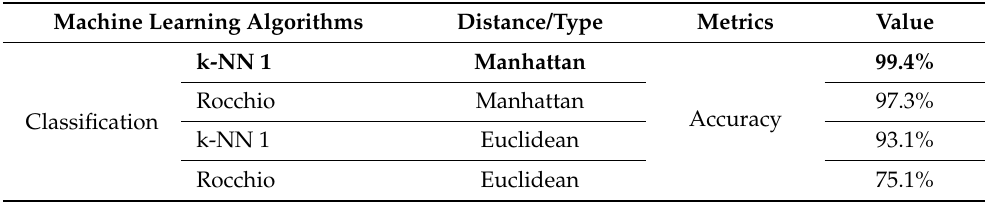
Table 3. Results of machine learning algorithms used for liquid volume predictions.